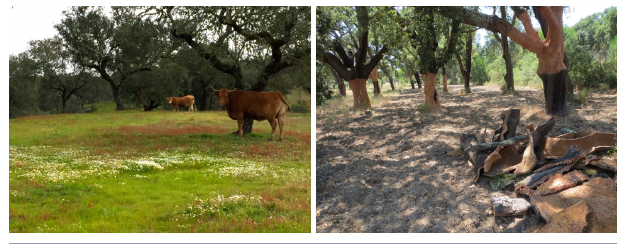
Fig. 2 . Examples of holm oak ( Quercus ilex , left) dominated dehesa and cork oak ( Quercus suber , right) dominated